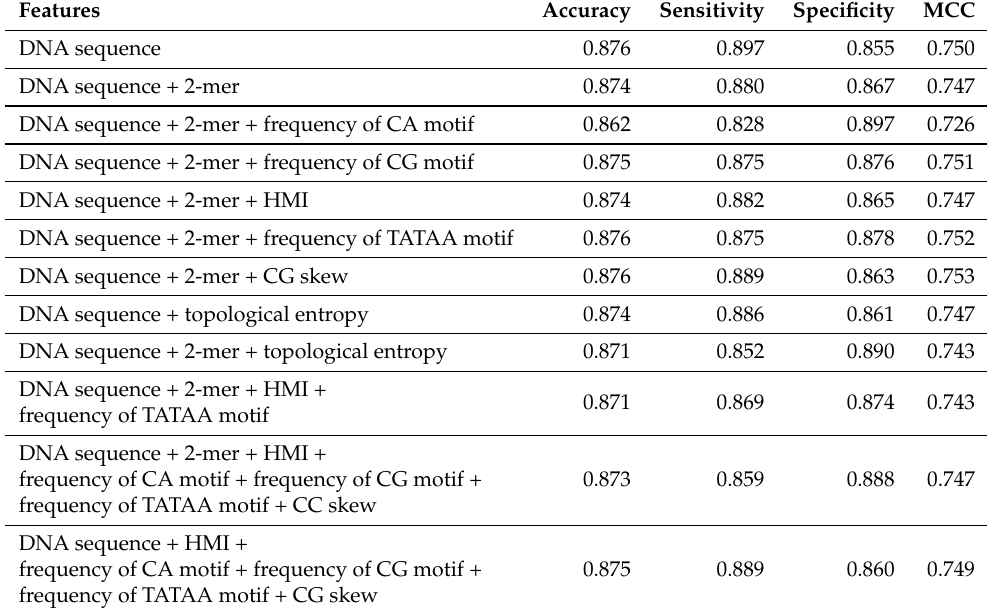
Table 3. Contribution of additional features in the CNN model of Medicago truncatula